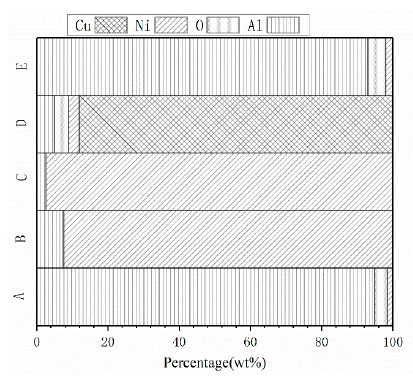
Figure 5. The point EDS results of A-E.